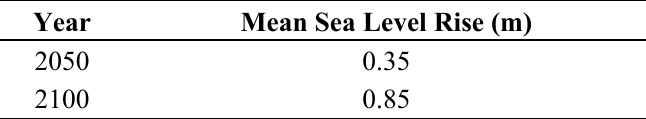
Table 5. The scenarios of mean sea level